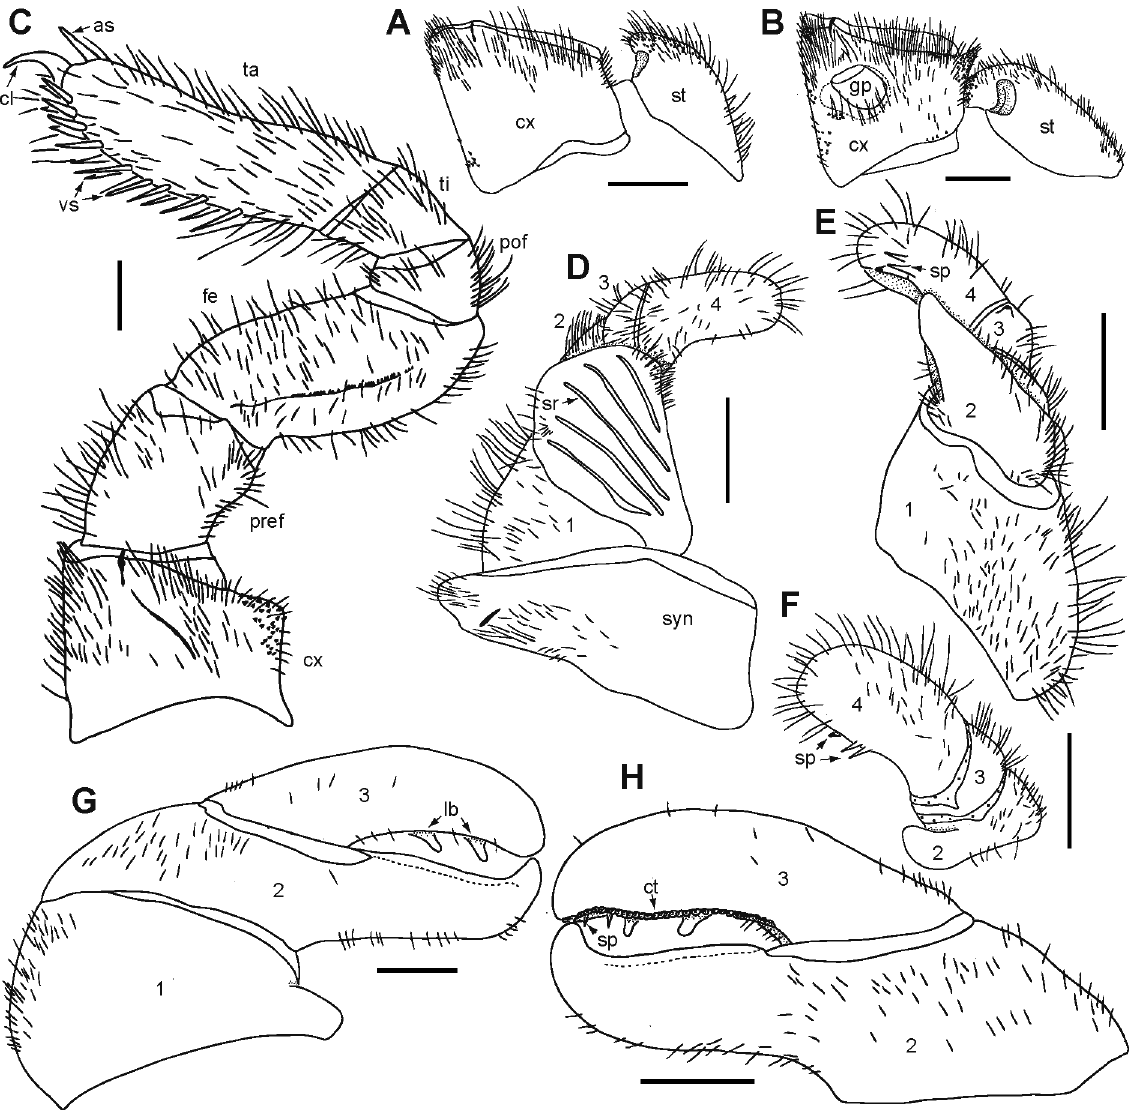
Fig. 5. Sphaeromimus kalambatritra sp. nov., schematic drawing, ♂, holotype ( CASENT 9068297-A). A . 1 st left coxae and stigma carrying plate. B . 2 nd left coxa and stigma carrying plate. C . 9 th left leg. D . Left anterior telopod, anterior view. E . Left anterior telopod, posterior view. F . Left anterior telopod, lateral view. G . Left posterior telopod, anterior view. H . Left posterior telopod, posterior view. Abbreviations: as = anterior spine; cl = claw; ct = crenulated teeth; cx = coxa; fe = femur; gp = gonopore; lb = lobe; pof = postfemur; pref = prefemur; sp = spine; sr = stridulation rib; st = stigmatic plate; syn = syncoxite; ta = tarsus; ti = tibia; vs = ventral spine; 1–4 = podomeres. Scale bars = 1